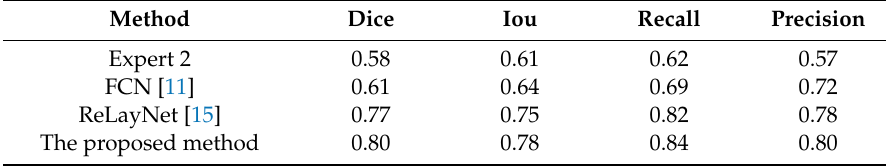
Table 2. Quantitative comparison of the segmentation results.